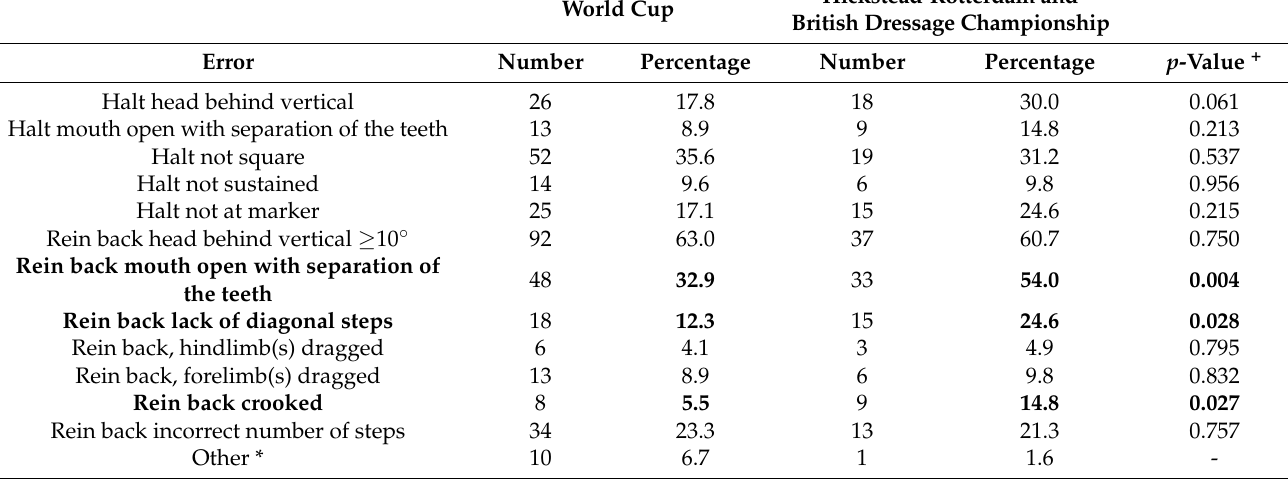
Table 7. Summary of the frequency of occurrence of errors in the movement ‘halt at C, immobility, rein back five steps, proceed in collected trot’ for all venues combined (146 competitors) for the World Cup Grand Prix Western League qualifying competitions ( n = 7) and the finals ( n = 2) (median score was 2/13 [interquartile range, IQR 1–3; range 0–8]) [10] and the combined results for the Hickstead-Rotterdam Grand Prix Challenge and the British Dressage Grand Prix National Championship ( n = 61; data were missing for 3 competitors) (median score 3/13 [IQR 2–4; range 0–7]). Significant differences are highlighted in